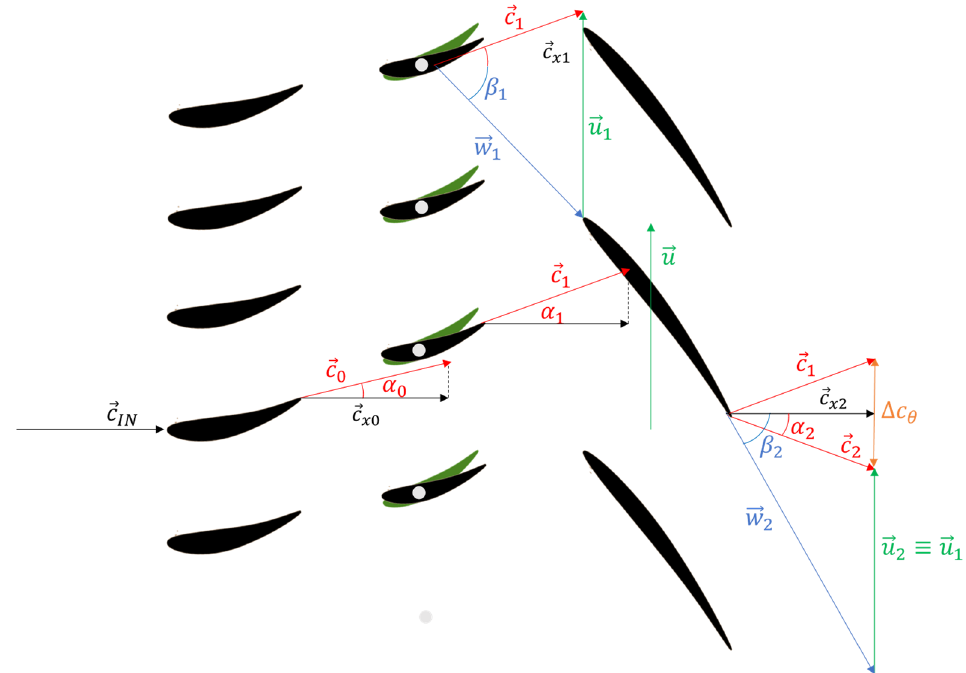
Figure 5. Guide vane and rotor blade profiles in the meanline blade-to-blade plane and flow velocity triangles at off-design conditions ( k u = 1, simple guide vane regulation)—flow rate increased.